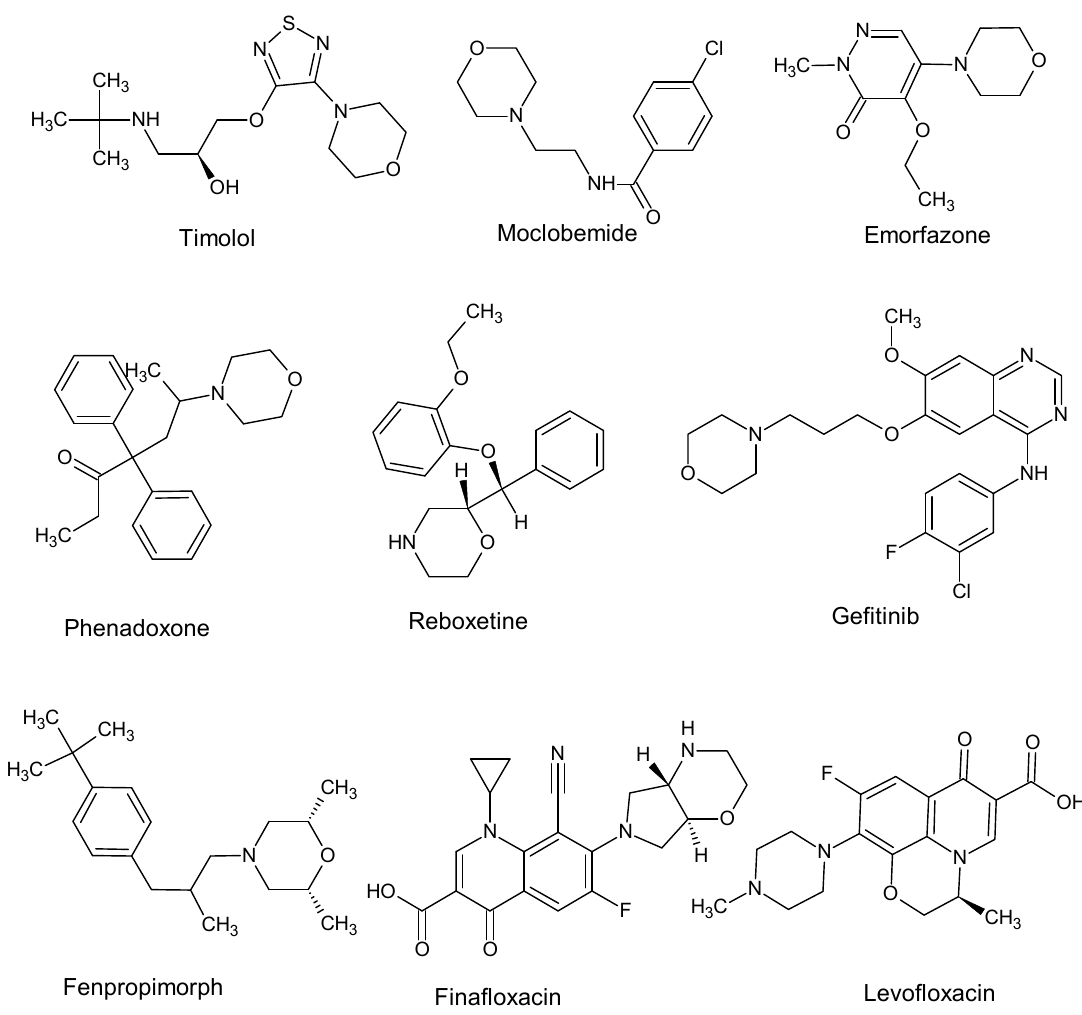
Figure 2. Marketed drugs containing morpholine moiety.